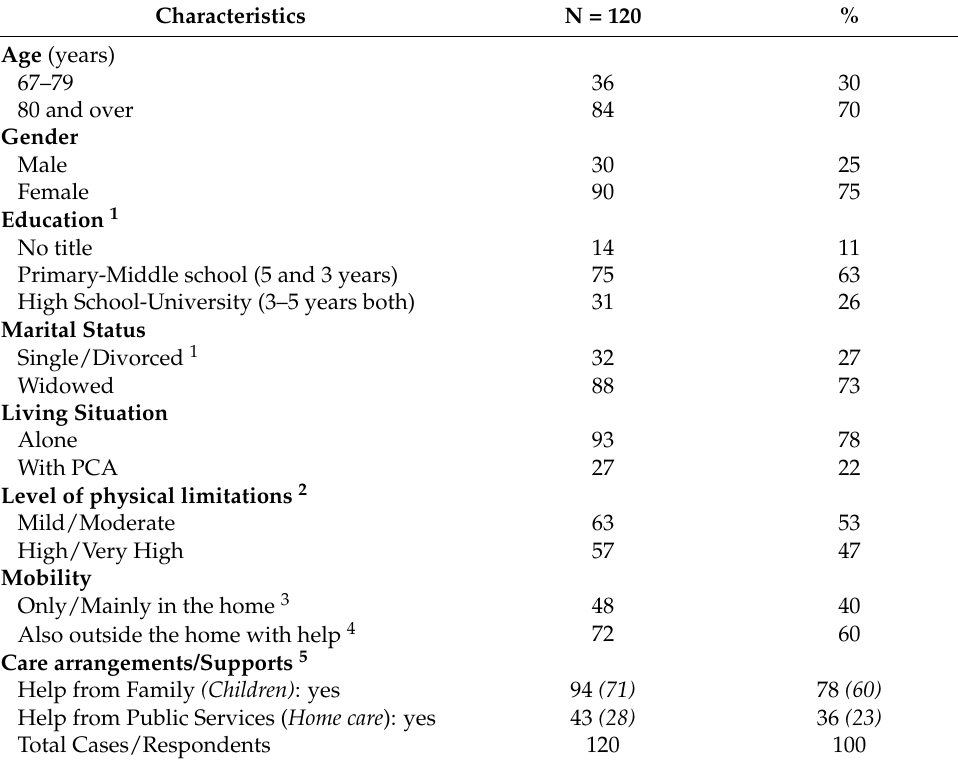
Table 2. Sample Characteristics (absolute values/ n and